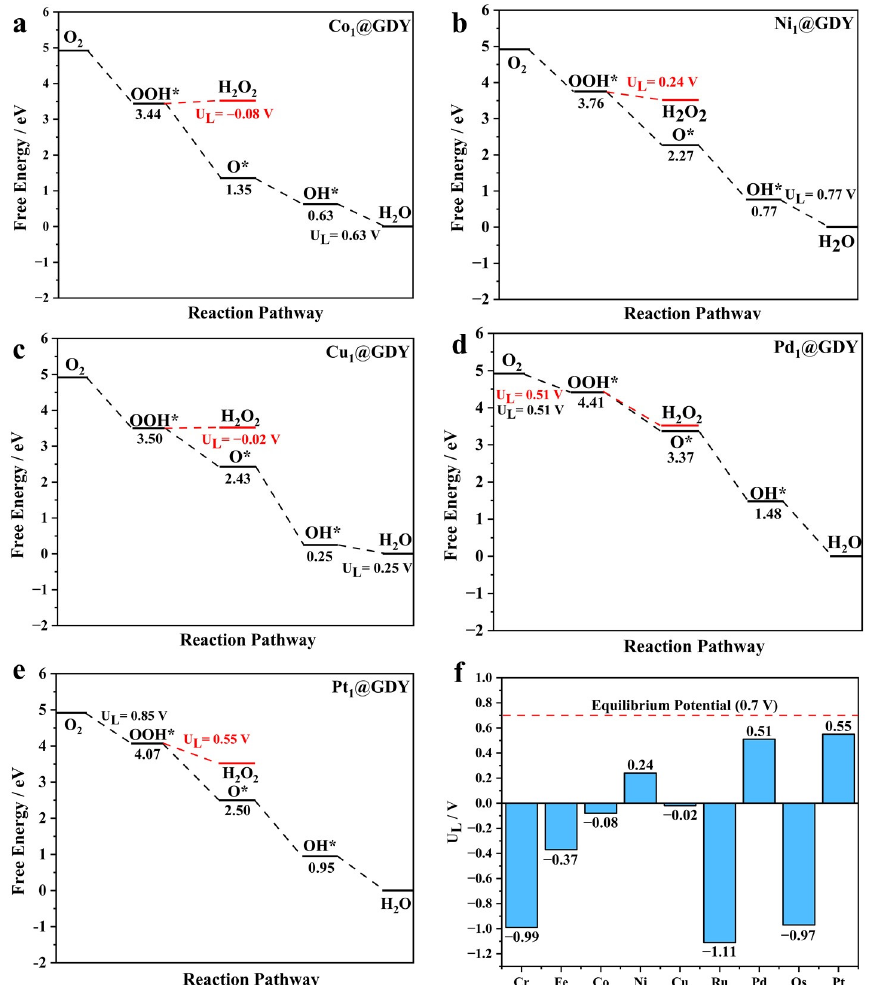
Figure 3. Free energy diagrams of the 2e − and 4e − ORR on ( a ) Co 1 @GDY, ( b ) Ni 1 @GDY, ( c ) Cu 1